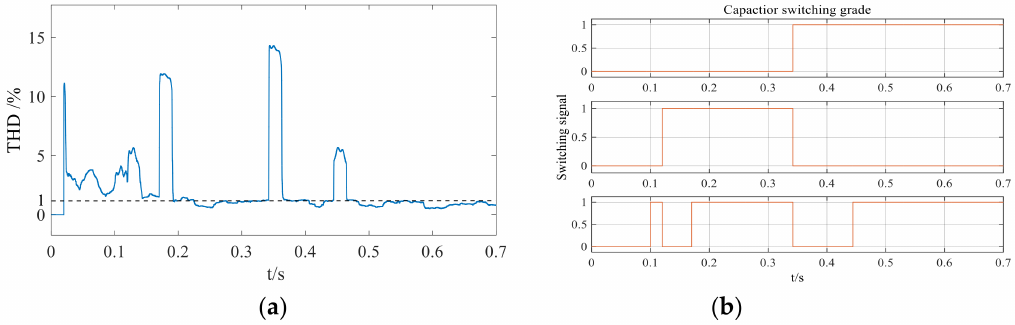
Figure 15. ( a ) THD waveform; ( b ) Capacitor switching